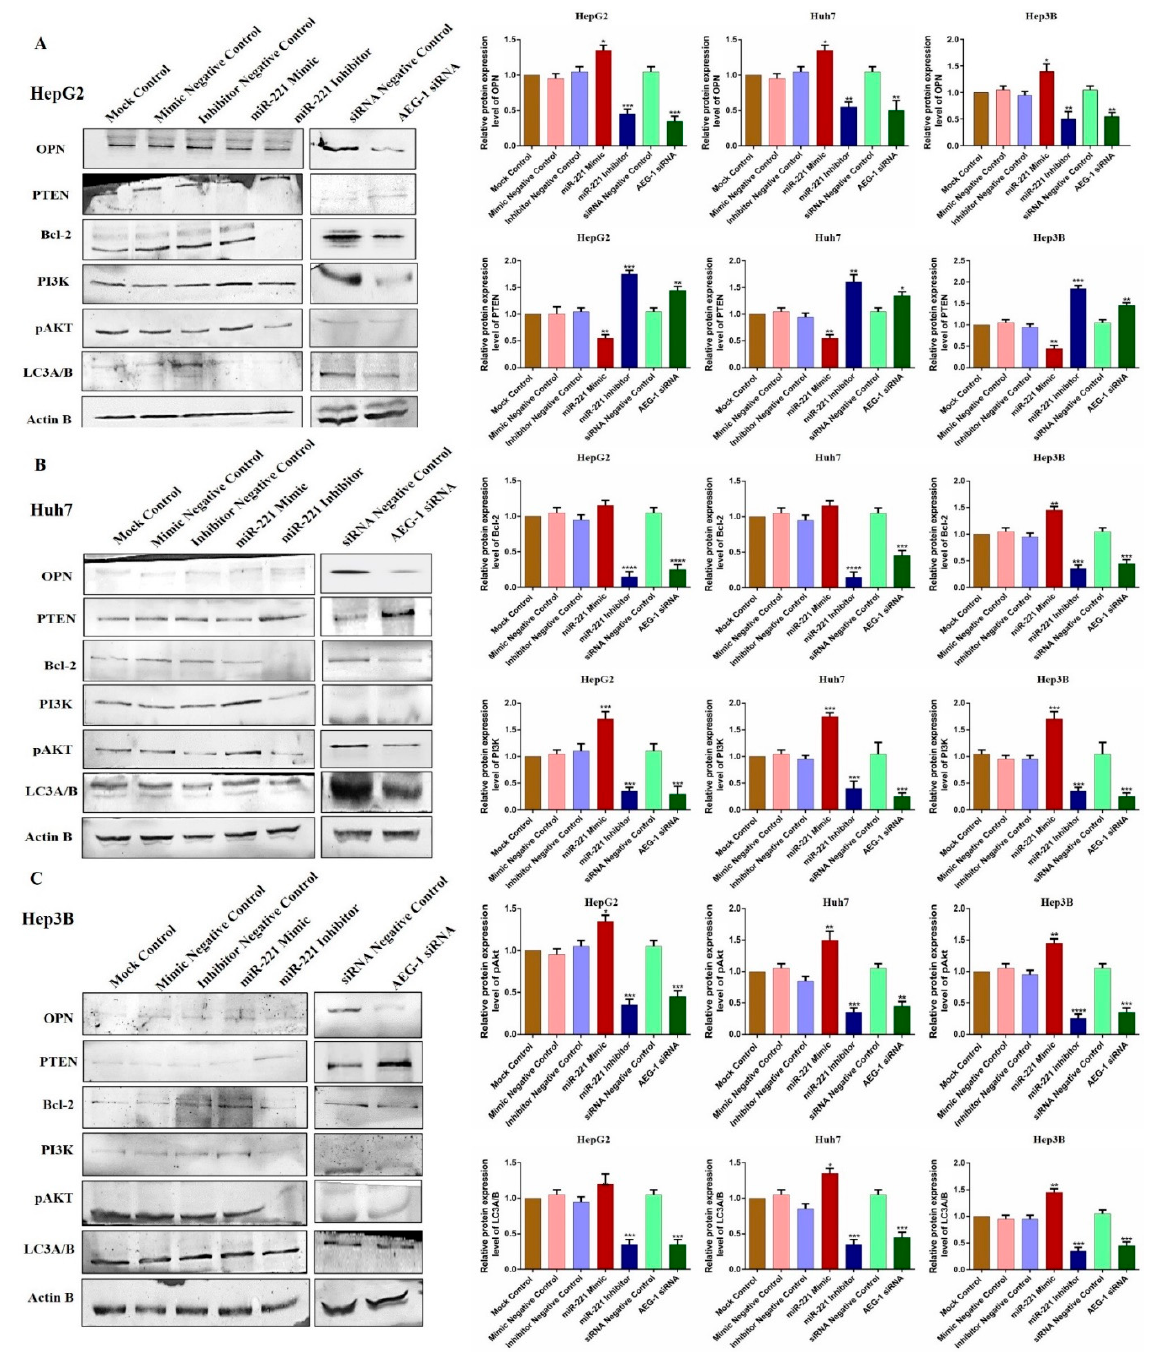
Figure 8. Ectopic expression of AEG-1/miR-221 dysregulates apoptosis and autophagy regulatory protein levels in HCC cell lines. The relative expressions of apoptosis (OPN and Bcl-2), autophagy (LC3A/B), PTEN, and PI3K/Akt proteins were analyzed by western blotting in the mock control, miR-221 mimic, miR-221 inhibitor, AEG-1 siRNA, and corresponding controls transfected HepG2 ( A ), Huh7 ( B ), and Hep3B ( C ) cells using β -actin as an internal control. Error bars are represented as mean ± s.d. and * p < 0.05, ** p < 0.01, *** p < 0.001, **** p < 0.0001 compared to the control group. ns: non-significance.